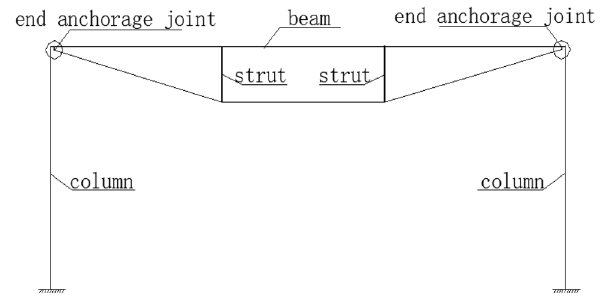
Fig. 1 Schematic diagram of external prestressing